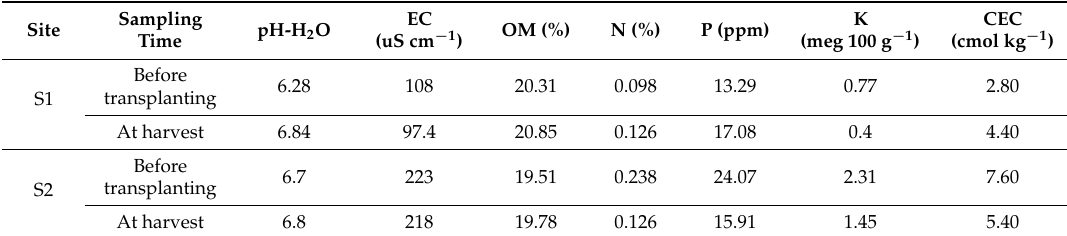
Table 2. Measured chemical soil